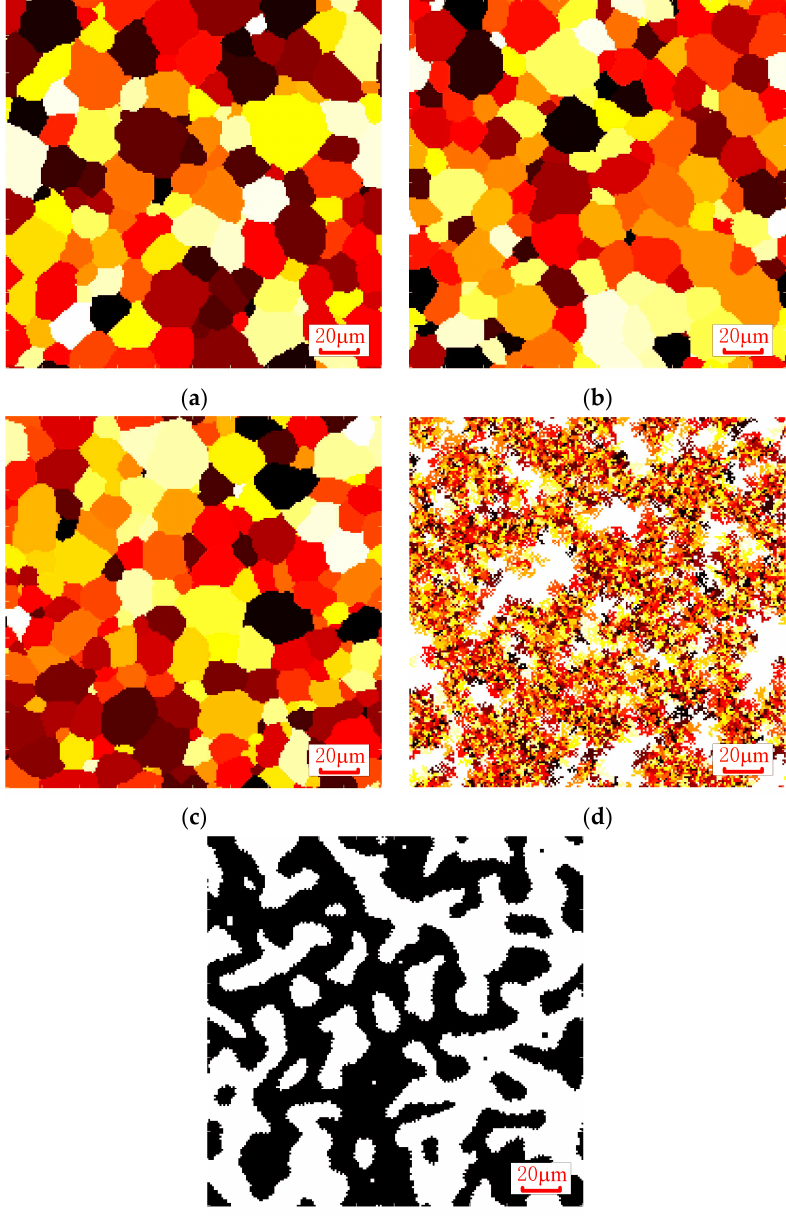
Figure 8. Microstructure distribution at different positions along the grinding depth. ( a ) 0 mm; ( b ) 0.08 mm; ( c ) 0.16 mm; ( d ) 0.24 mm; (e) 0.30 mm. ( a – c ) Different colors represent austenite grains with different crystallographic orientations; ( d – e ) white represents ferrite; black represents pearlite; other colors represent austenite grains with different crystallographic orientations.